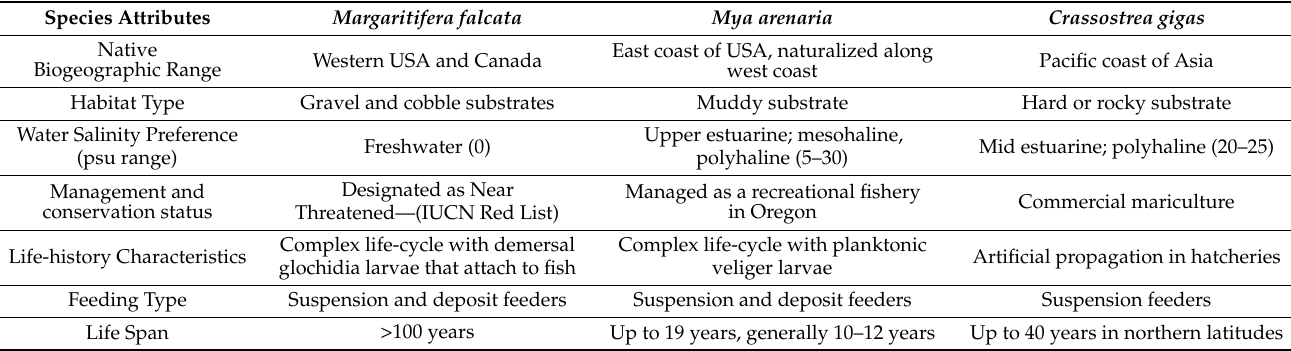
Water Salinity Preference (psu